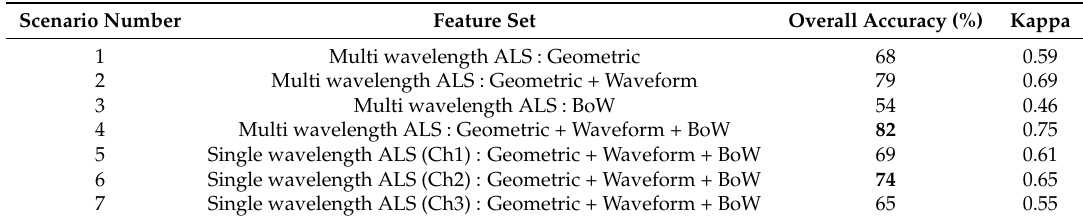
Table 5. Results for classification of tree species and dead trees using the test data set. The best result of each test case is highlighted in